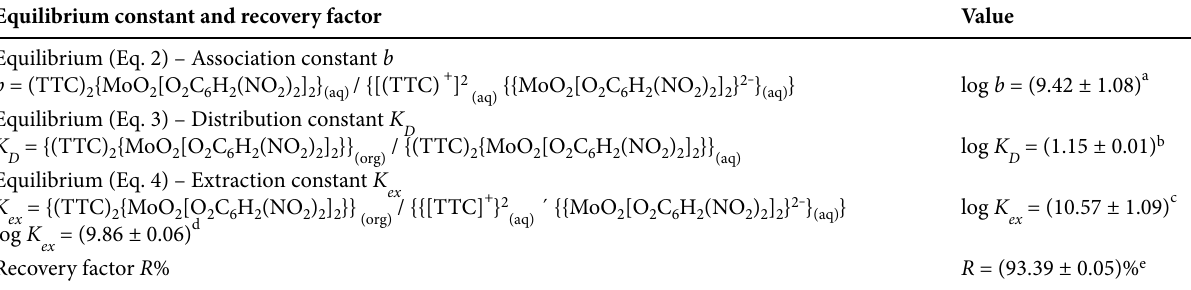
Table 3. Values of the equilibrium constants and the recovery factor Equilibrium constant and recovery factor Equilibrium (Eq. 2) – Association constant